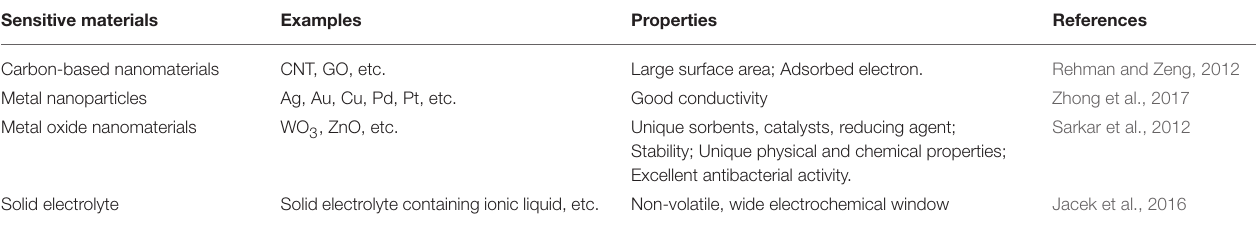
TABLE 1 | The properties of sensitive